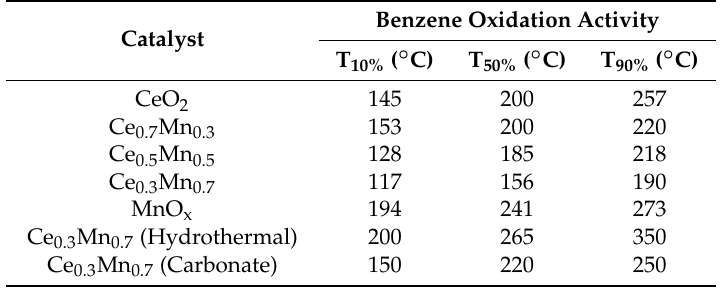
Table 1. Catalytic activities of CeO 2 , MnO x and Ce x Mn 1 − x catalysts.